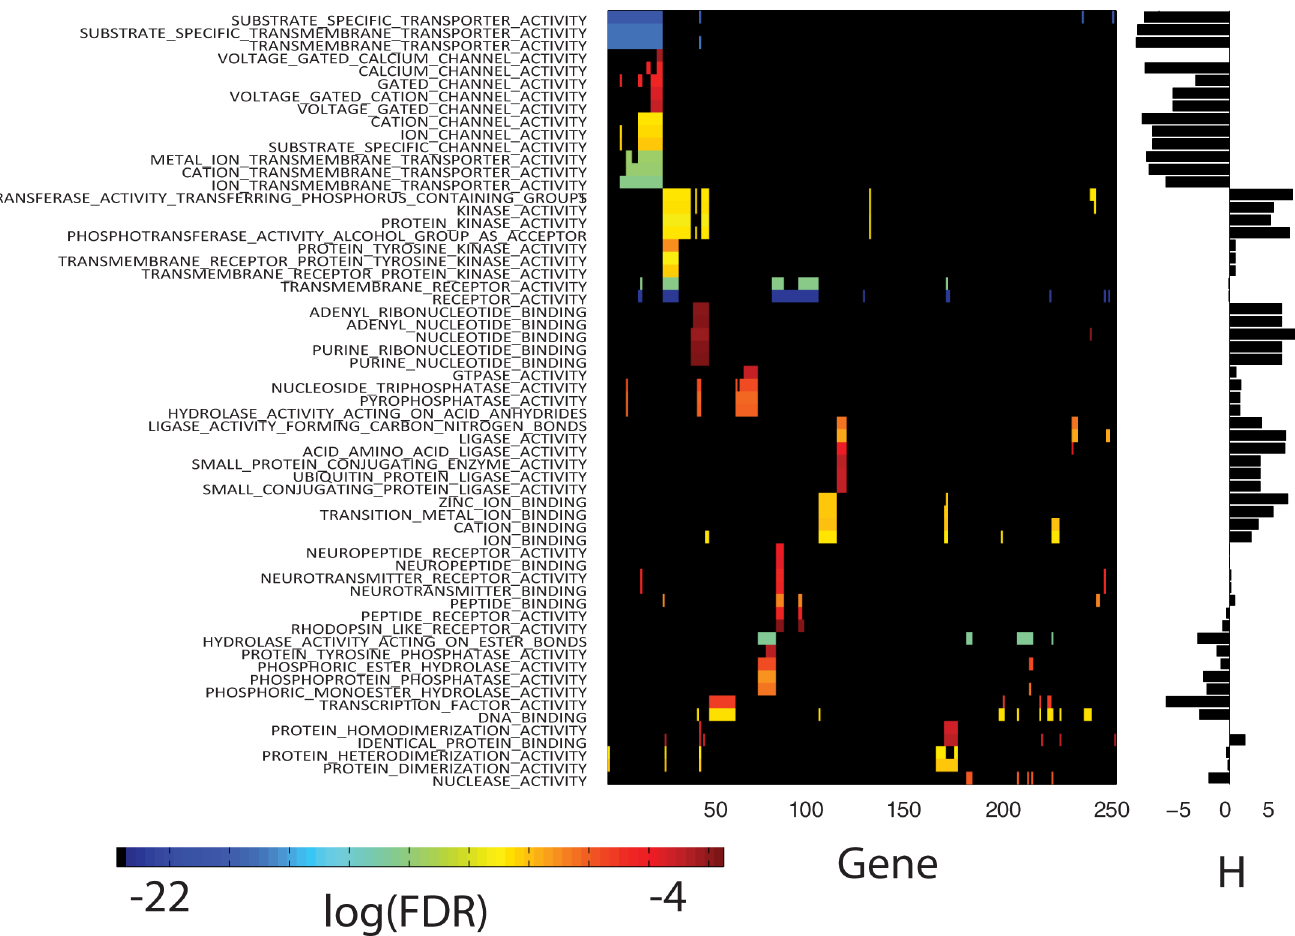
Fig 4. Clustered plot of the topmost significant GSEA pathways and the genes appearing in each pathway. Rows (GSEA Pathways) and columns (one’s for genesin each pathway, zeroes otherwise)have been clusteredusing a Minkowski’s distancemetric and Wards linkage.Pathway genes in each row are colored spectrallyby their log(FDRq-value), (blue to red, most to least negative)as listed in S3 Table . FDR q-valueswere not used for clustering, only the presenceor absenceof pathway genes. The top 61 GSEA pathwayswere arbitrarily selectedfor displayto enhance readabilityof labels.The completeclusteredplot for all significant(FDR < 0.05) GSEA pathwaysappearsin S2 Fig . The pathway fitness scores, H, appearin the vertical bar plot at the right. A minimum of 5 pathway genesare requiredfor a non-zerofitness score.